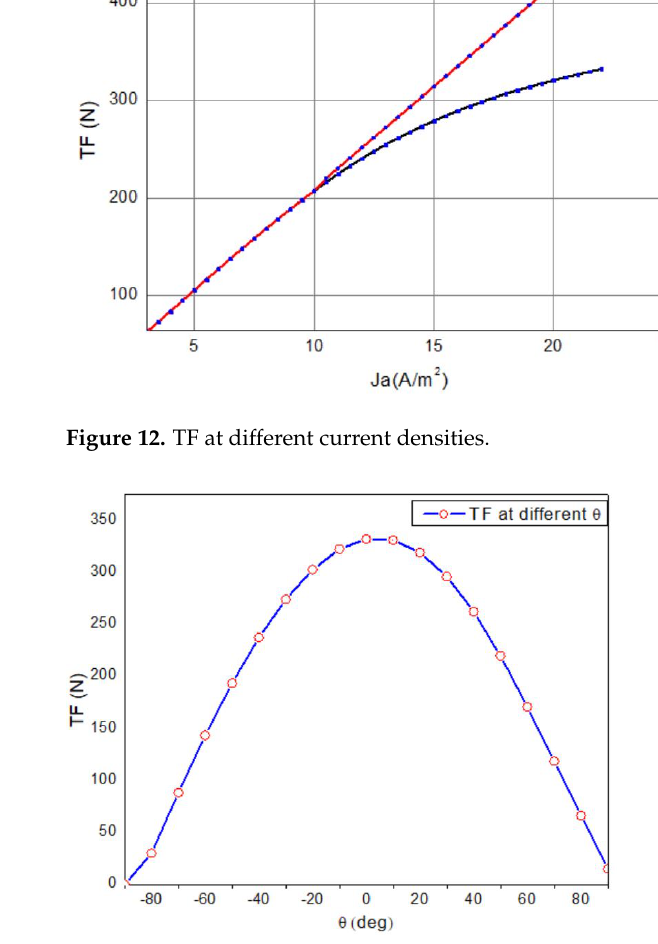
Figure 13. Thrust force at different starting